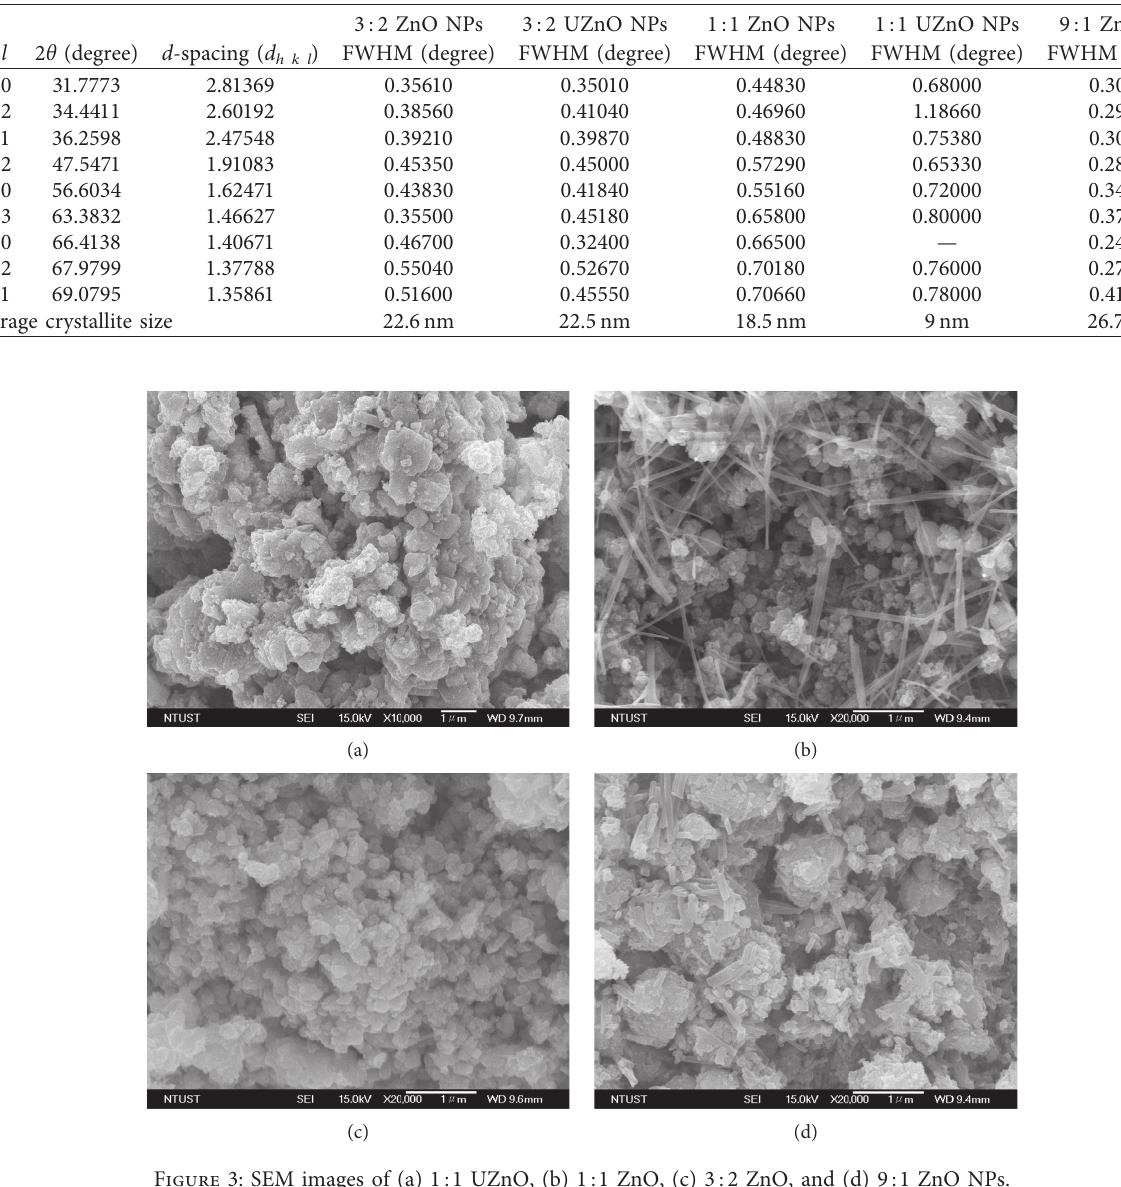
Table 1: FWHM values, average crystallite sizes calculated using Scherrer’s formula, d -spacing ( d uncalcinated ZnO NPs synthesized using zinc acetate dihydrate and Lippia adoensis leaf extract at ratios by volume of 3: 2, 1:1, and 9:1.